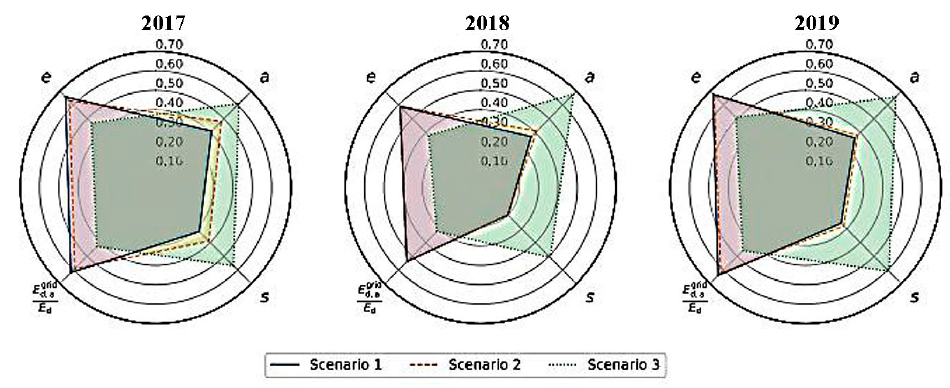
Figure 15. Comparison of established key performance parameters (s - self-consumption, a - au- tarky, e - emissions).